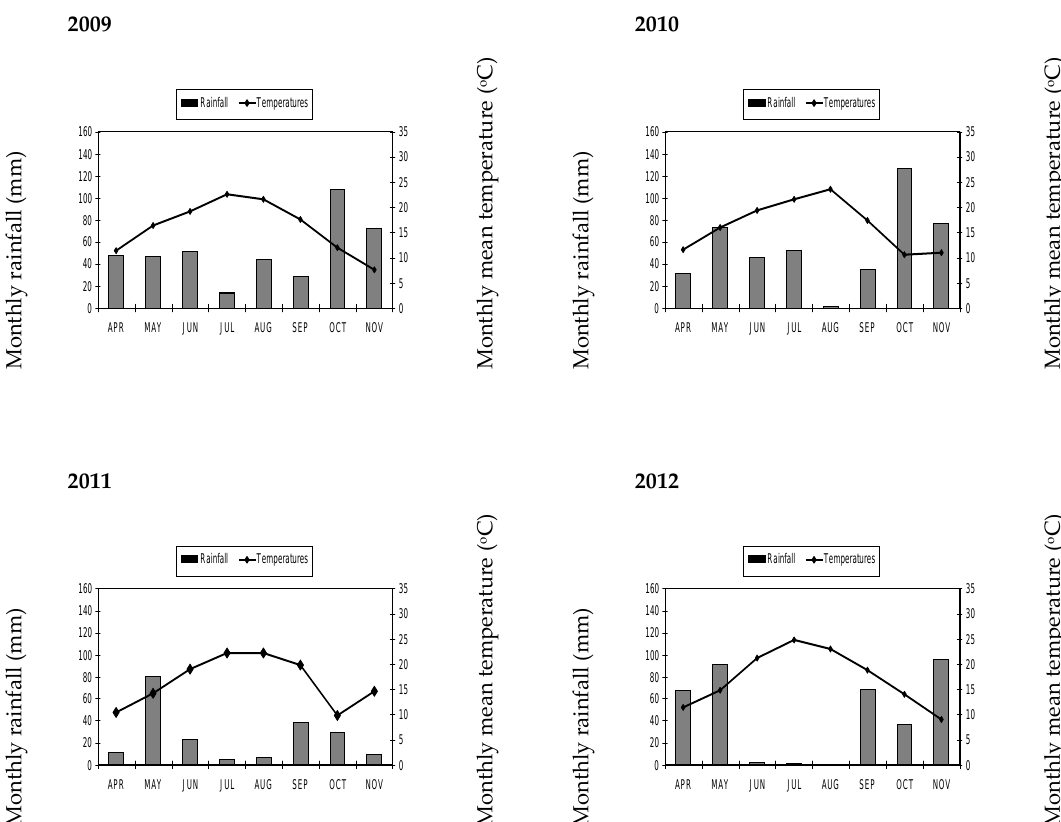
Figure 1. Basic weather data (mean monthly temperature in °C and rainfall in mm) based on daily records, for years 2009–2012.